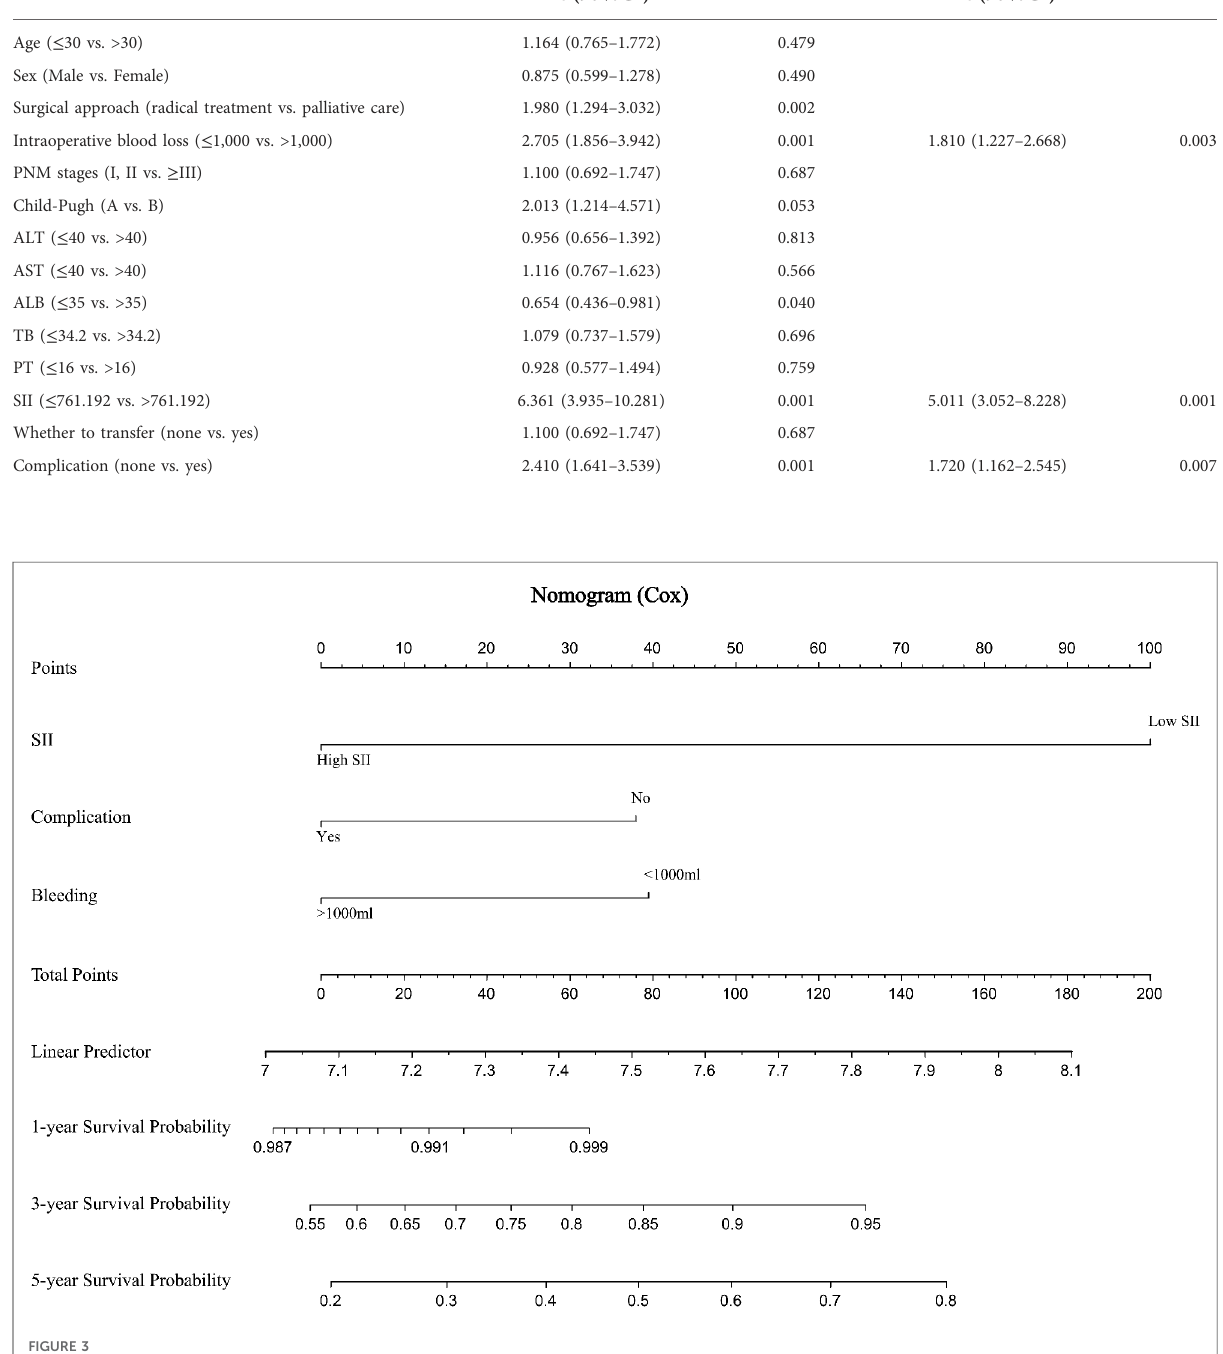
model can better represent the actual values. In the internal validation cohort, the validation C-index was 0.797 by bootstrapping validation analysis, which indicates that the